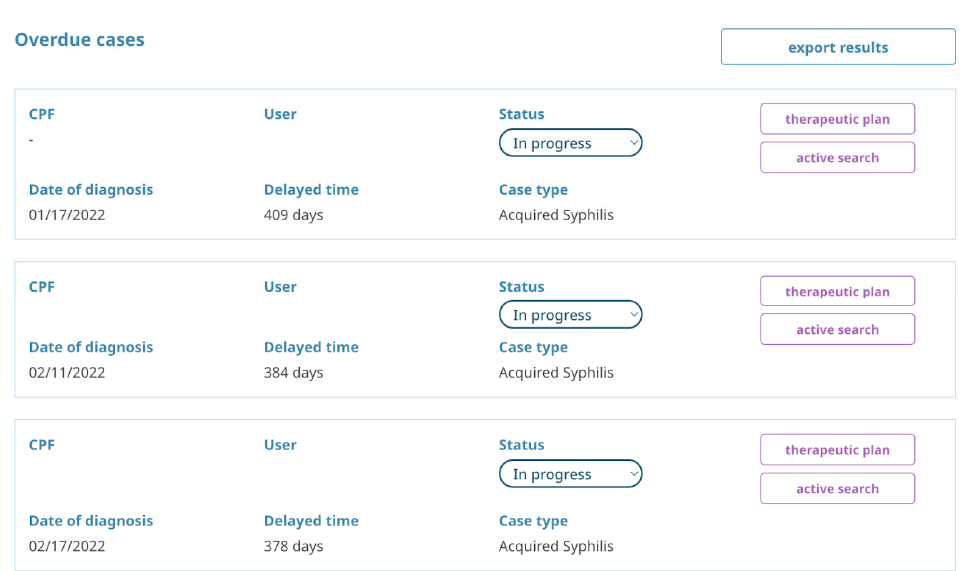
Figure A4. Reports. Figure A4. Reports.